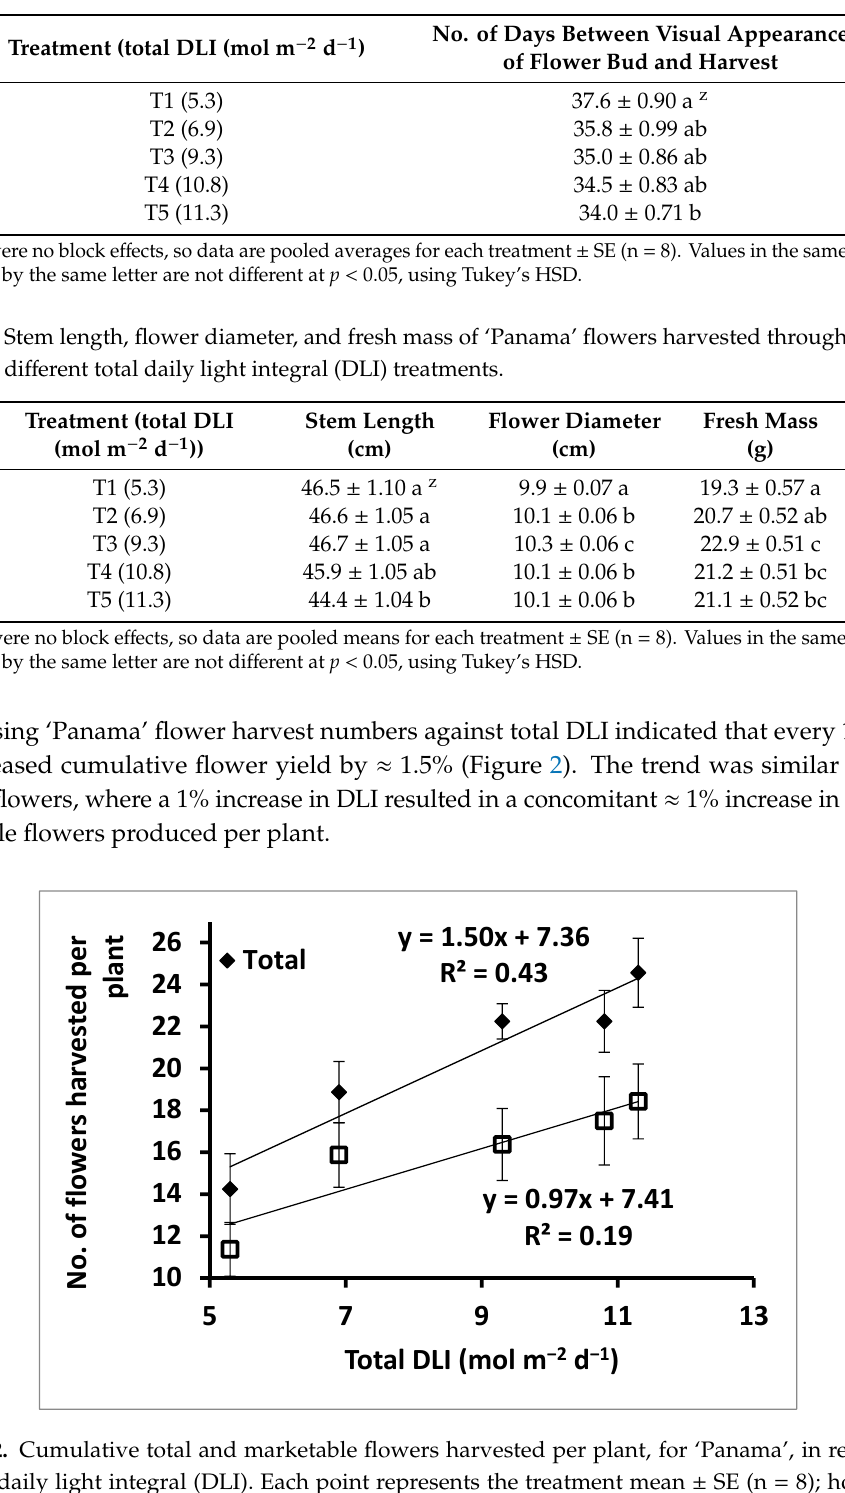
Table 3. Days between appearance of flower buds (i.e., stems ≥ 1 cm) and harvest for all ‘Ultima’ flowers harvested during the trial, for di ff erent total daily light integral (DLI) treatments.